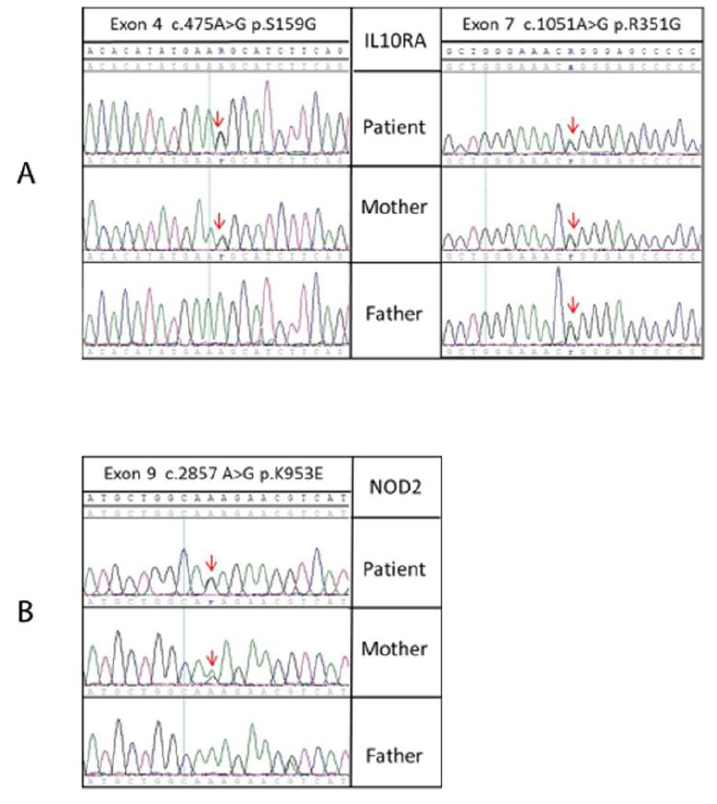
Figure 1. Sequence chromatograms from patient and parents of the IL10RA and NOD2 coding regions. ( A ) In the IL10RA exon 4 and exon 9, the arrows indicate the nucleotide substitution, c.475A > G and c.1051A > G, consisting, respectively, in the amino acid substitutions, S159G (A/G heterozygous patient and mother, A/A wild type father) and R351G; ( B ) in the NOD2 exon 9 sequence, the c.2857 A > G substitution consisted in an amino acid substitution, K953E (A/G heterozygous patient and mother, A/A wild-type